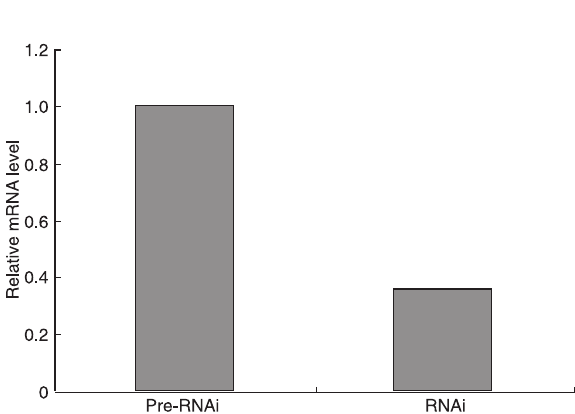
Figure 3. The effect of RNAi on HIF-1α expression examined by real-time RT-PCR. Analysis revealed that the levels of HIF- 1α mRNA were significantly down-regulated by 65% in the RNAi group compared to the pre-RNAi group (P < 0.01, t -test).